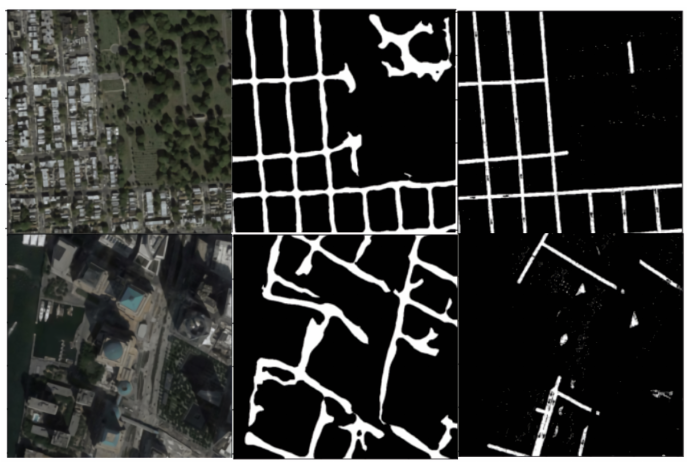
Figure 14. Examples of misclassifications (left to right in each row): satellite image, post-processed output, ground truth image.